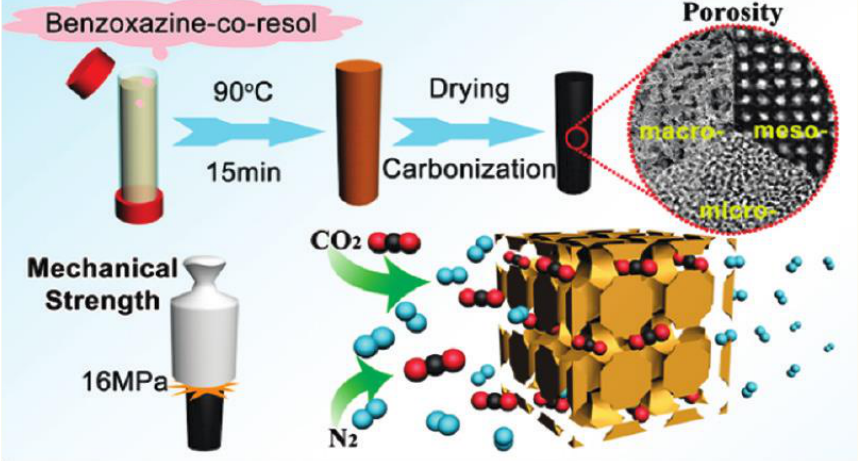
Figure 55. Benzoxazine-co-resol based porous carbon monoliths for high-performance CO 2 capture (reproduced from the work in [125] with permission).